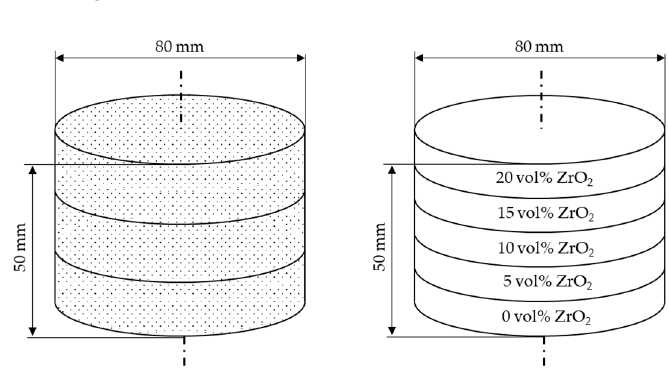
Figure 1. Types of specimens fabricated.